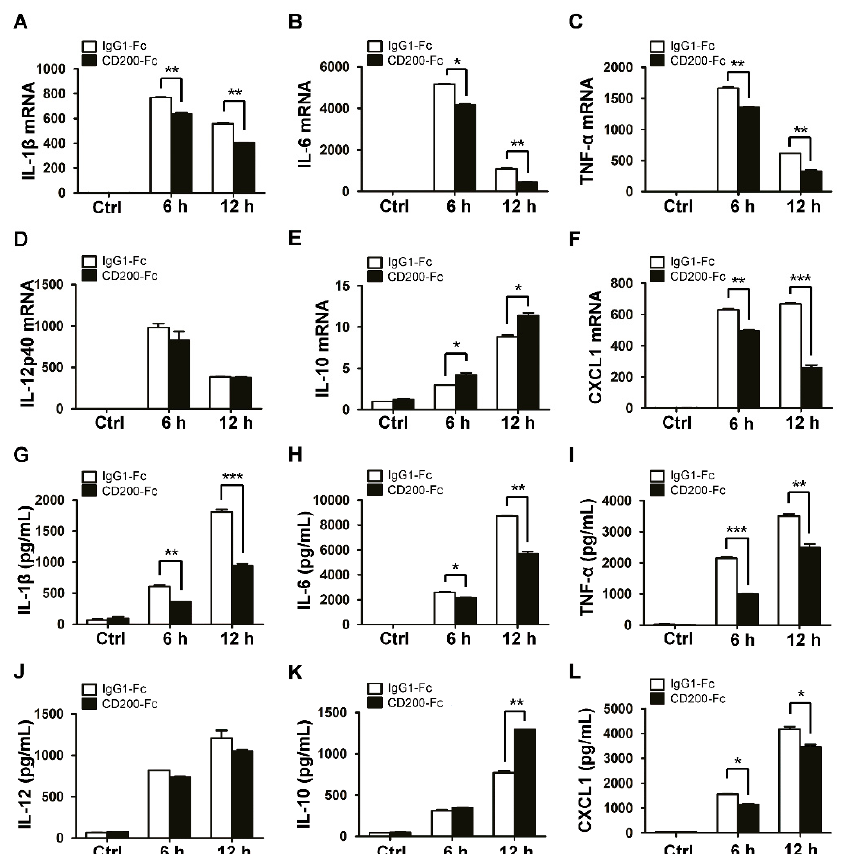
Figure 2. CD200 inhibits the production of inflammatory cytokines induced by S. aureus . Mouse BMDMs were pre-treated with CD200-Fc (2 μ g/mL) or IgG1-Fc (2 μ g/mL) for 1 h, and then stimulated with S. aureus (MOI = 1) for indicated time periods (0–12 h). ( A – F ) Relative mRNA expression levels of IL-1 β ( A ), IL-6 ( B ), TNF- α ( C ), IL-12p40 ( D ), IL-10 ( E ), or CXCL1 ( F ) were detected by qPCR, with β -actin as an internal control. ( G – L ) The amount of IL-1 β ( G ), IL-6 ( H ), TNF- α ( I ), IL-12 ( J ), IL-10 ( K ), or CXCL1 ( L ) in the cell culture supernatant was determined by ELISA. Results are expressed as the mean ± SD of three independent experiments; * p < 0.05, ** p < 0.01, *** p < 0.005.